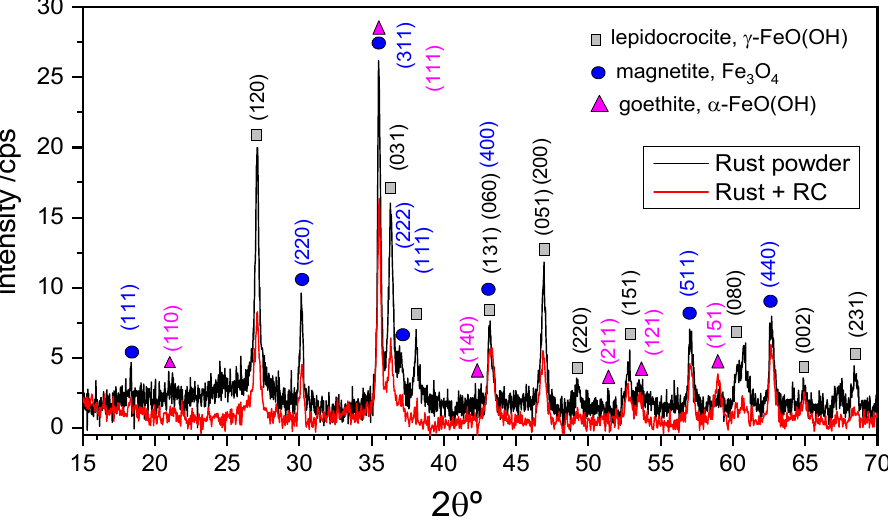
Figure 3. Detail of the X-ray patterns corresponding to 1RC:0.3GO and 1RC:1.2GO ratios. The X-ray pattern of GO is given in the insert.